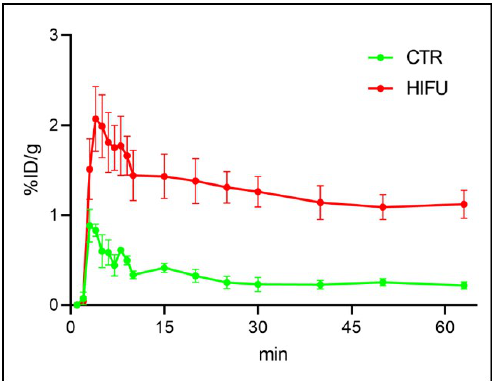
Figure 5. Dynamic PET scans of [ 11 C] topotecan injected mice with ( n = 4) and without HIFU treatment ( n = 4) demonstrating increased peak and retained topotecan in the brain of HIFU-treated animals.